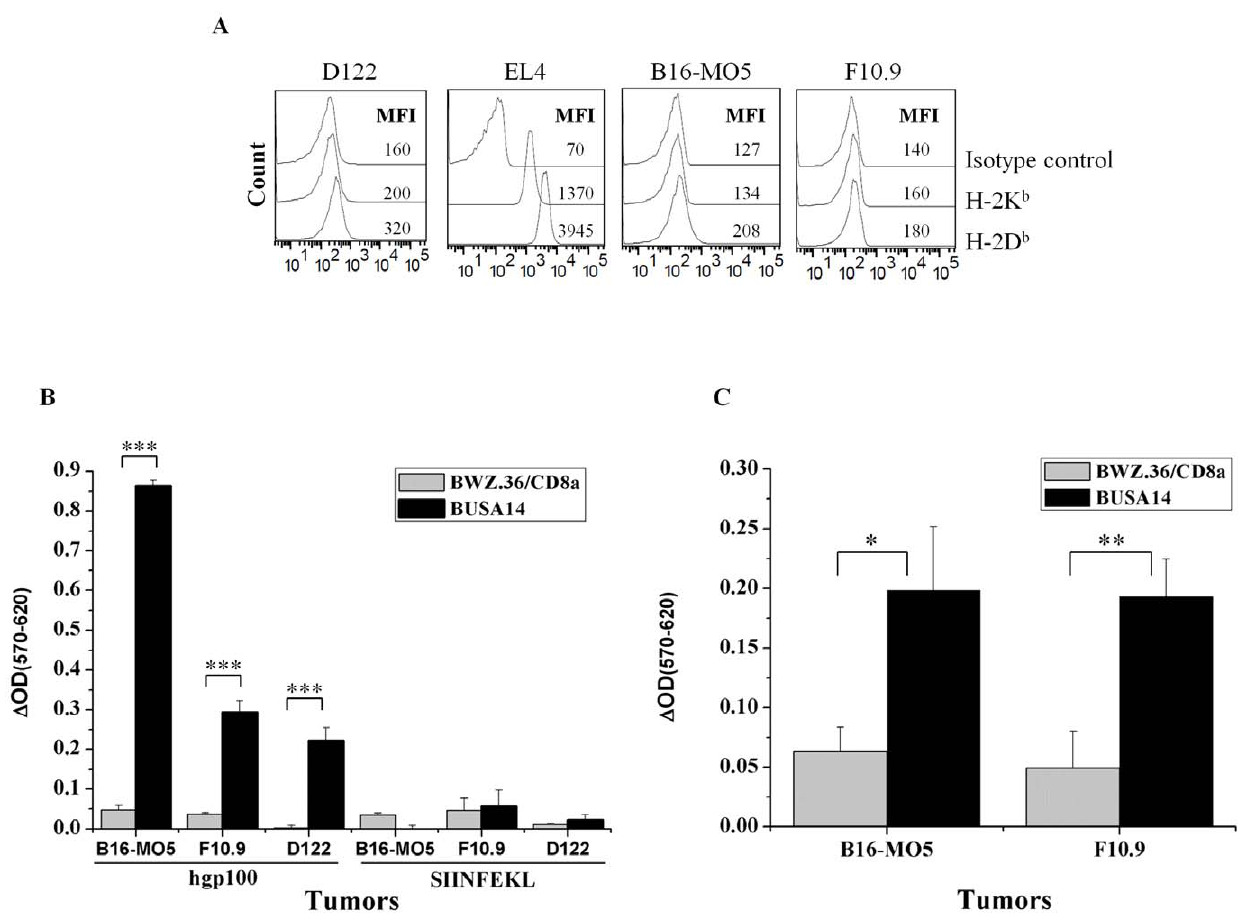
Figure 4. BUSA14 are activated by hgp100 25–33 and mgp100 25–33 presented on melanoma cell lines. A. B16-MO5, F10.9, D122 and EL4 tumor cell lines were analyzed by flow cytometry with monoclonal antibodies to H-2K b and H-2D b to analyze MHC-I membranal expression. MFI values are presented in the figure. B. Twenty thousand B16-MO5, F10.9 and D122 cells were loaded with 30 m g/ml hgp100 25–33 or SIINFEKL peptides. Cells were washed and co-incubated with 6 6 10 4 BUSA14 and BWZ.36/CD8 a for 12 hours. Cells were then lysed and b -Gal enzymatic activity was monitored with CPRG. Cultures with D122 served as reference for CPRG background levels. Representative results (1 of 3 experiments) are presented as D OD (sample OD-background OD) measured after 12 hours. C. Sixty thousand BUSA14 and BWZ.36/CD8 a cells/well were incubated overnight, in triplicates, with 2 6 10 4 B16-MO5, F10.9 or D122 tumor cell lines. Representative results (1 of 2 experiments) are presented as D OD (sample OD- background OD) measured after 24 hours. Statistical analysis was done using student T test (*p , 0.05, **p , 0.01, ***p ,